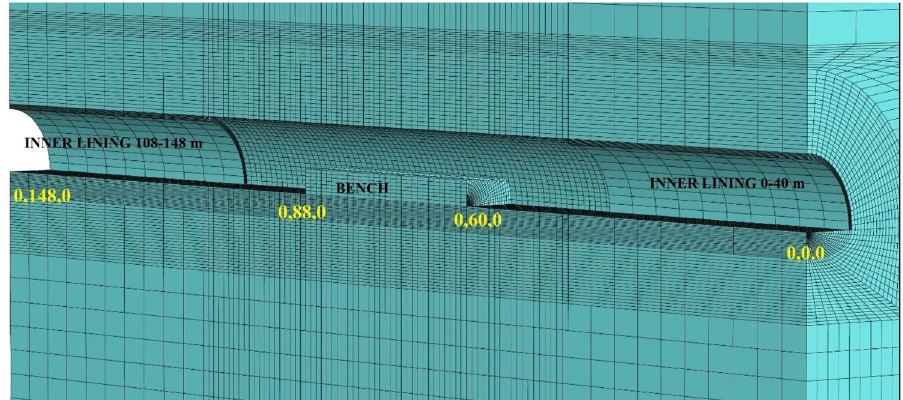
Figure 16. Excavation steps.